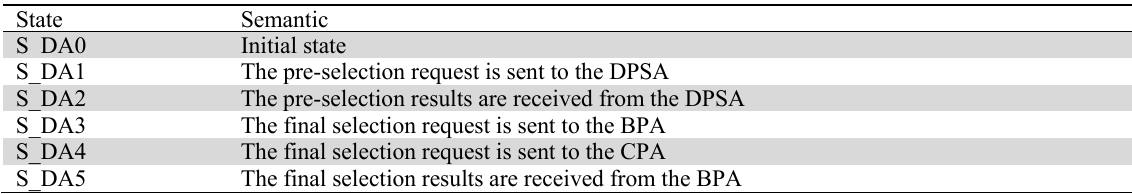
Fig. 2. State transition diagram of the DA The DA's states and their semantics